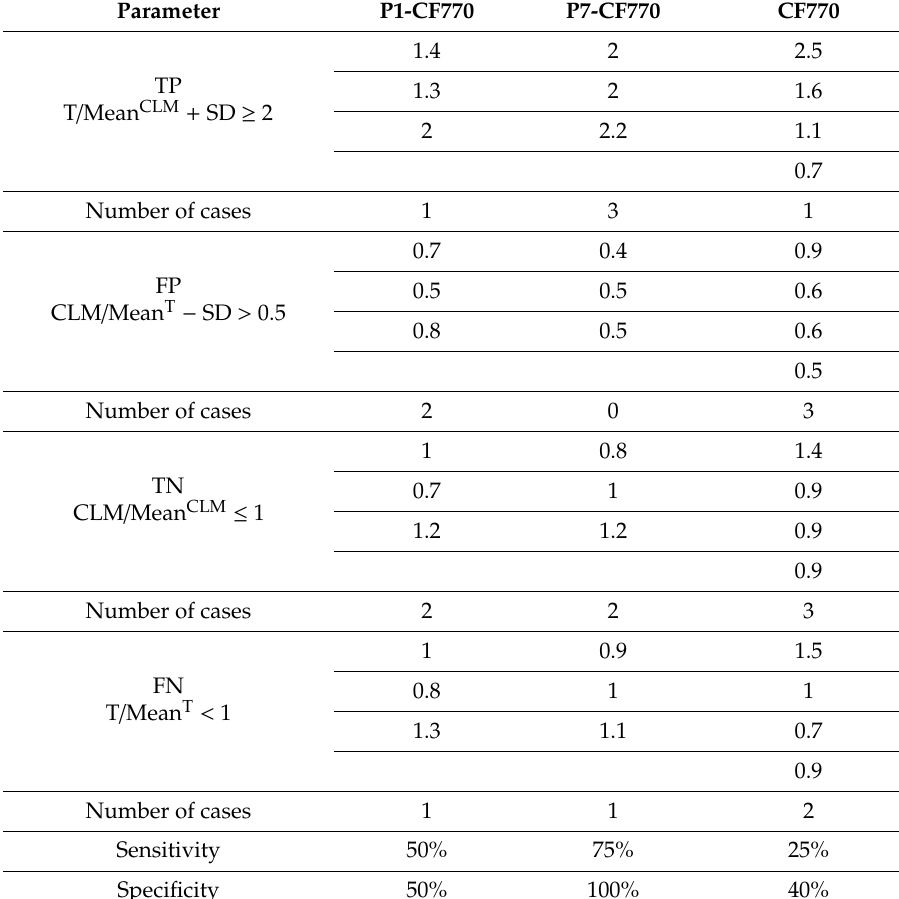
Table 2. Estimation of true positive (TP), false positive (FP), true negative (TN), and false negative (FN) cases within the experimental groups of mice injected with P1-CF770, P7-CF770 or CF770 alone. The results obtained at 2 h after the injection of imaging probes were normalized to the signal measured on non-injected mice and exploited to finally estimate the sensitivity and specificity of the three near-infrared (NIR) imaging probes. Parameter P1-CF770 P7-CF770 CF770 TP T / Mean CLM + SD ≥